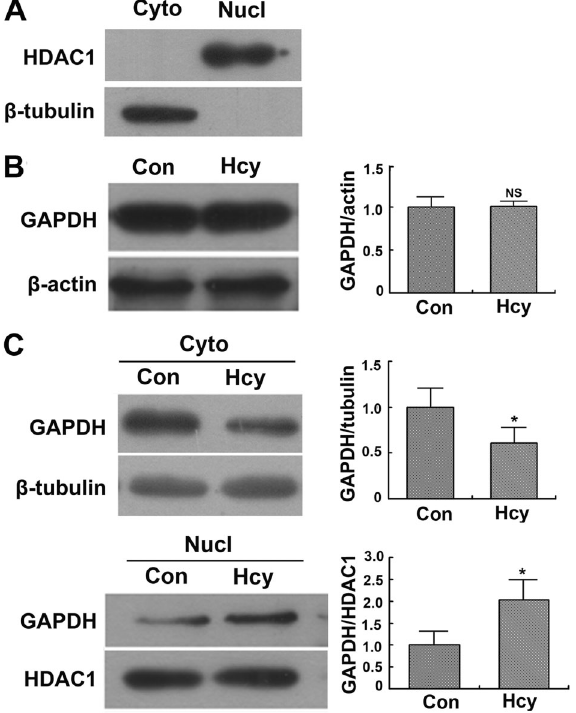
Figure 4. Translocation of glyceraldehyde 3-phosphate dehydro- genase (GAPDH) detected by Western blotting. Cytoplasmic (Cyto) and nucleic (Nucl) proteins were separated from Neuro2a cells incubated in the presence of 5 mM homocysteine (Hcy) or absence (Con) of Hcy for 48 h. The protein levels of GAPDH in subcellular fractions were detected by Western blotting with beta-tubulin as control. A , Puri fi cation of subcellular fractions was con fi rmed with the nucleic marker protein histone deacetylase 1 (HDAC1) and cytoplasmic protein marker beta-tubulin. B , Total GAPDH protein level. C , GAPDH protein levels in cytoplasm and nucleus. *P o 0.05 (Student-Newman-Keuls test). NS: not signi fi